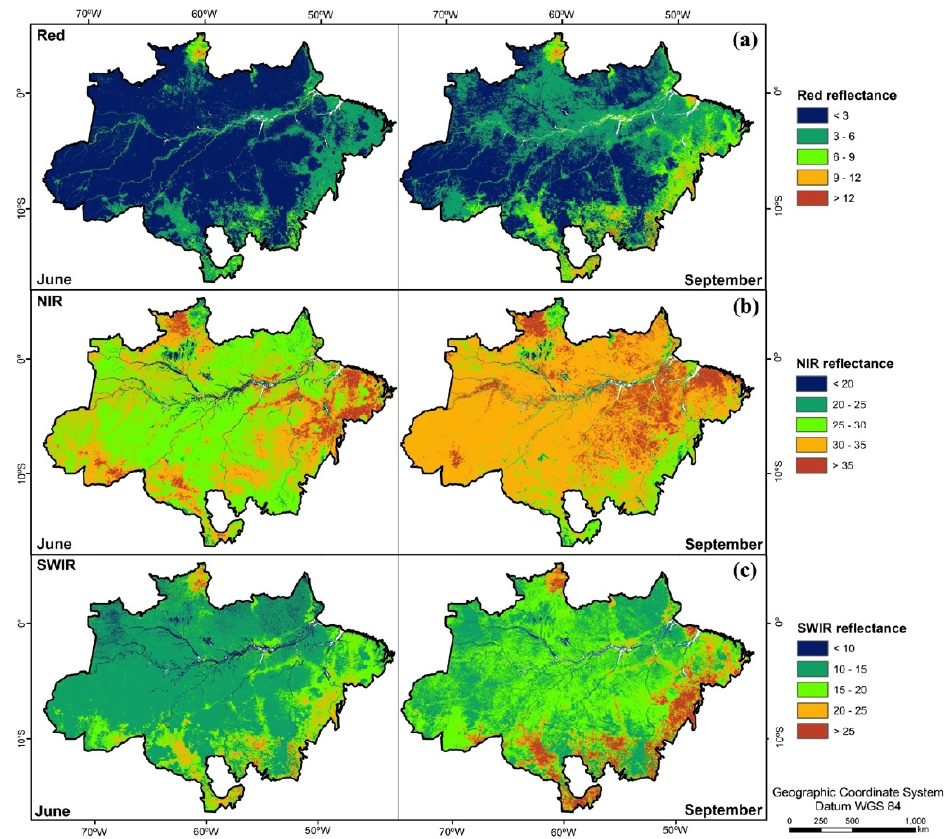
Figure 6. Variations in monthly average surface reflectance (2000–2014) for MODIS (MAIAC) data non–corrected for BRDF e ff ects in bands ( a ) 1 (red), ( b ) 2 (near infrared—NIR), and ( c ) 6 (shortwave infrared—SWIR). For all bands, a reflectance increase is observed from the beginning (June) to the end (September) of the Amazonian dry season.